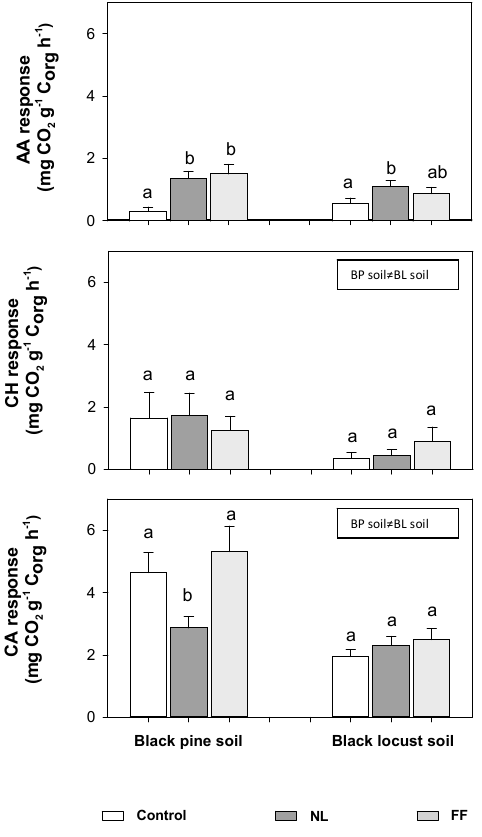
Figure 4. Changes in mineralization rate (MR) and microbial biomass (MB) after amendment of black pine and black locust mineral soil with water extracts of black locust forest ‐ floor litter. Changes are presented as percent of MR and MB in non ‐ amended (control: dashed line) soil (0–5 cm depth) and reported as the mean (±SE) from 20 samples. Different lowercase letters indicate statistically significant differences between the two soils ( t ‐ test, p < 0.05).